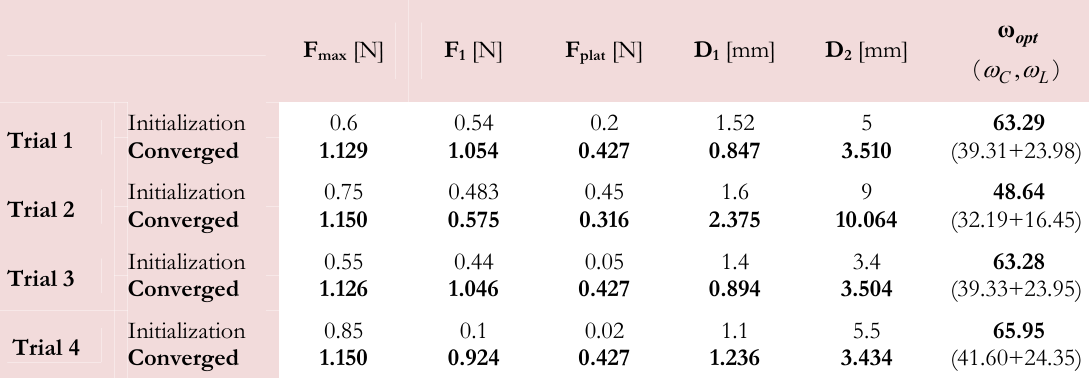
 ) and from the load – elongation curve ( C